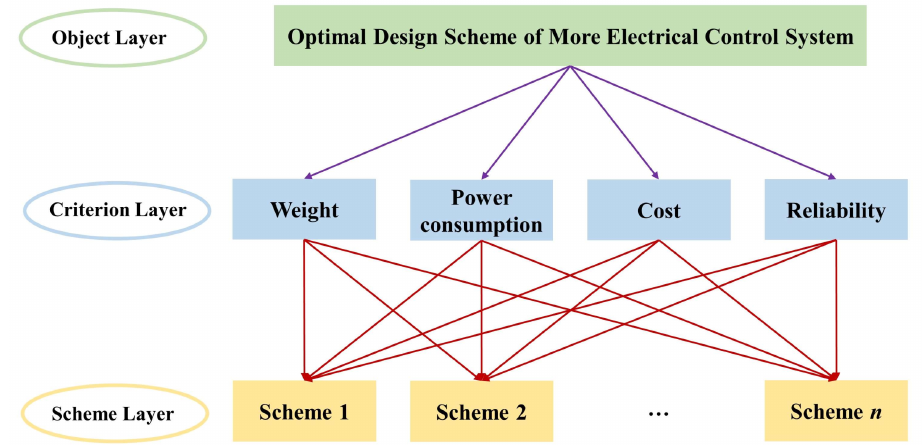
Figure 8. Three-level hierarchical framework of